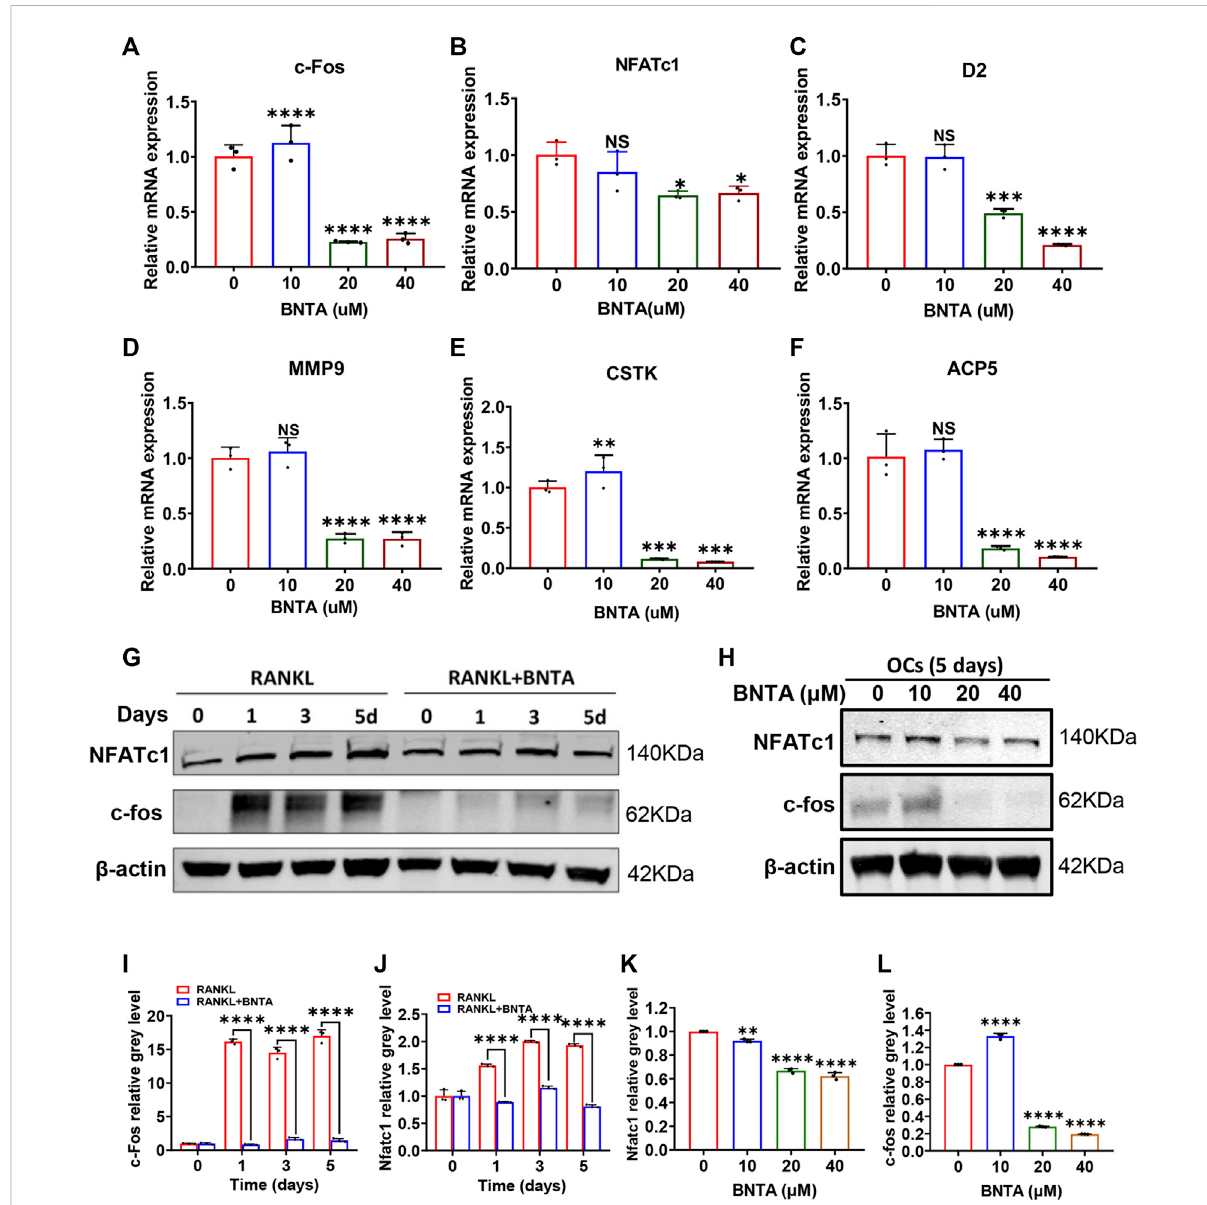
FIGURE 3 BNTA attenuated osteoclast-related gene expression and inhibited NFATc1 activation. (A – F) qPCR analysis of osteoclast-related gene expression of c-fos, NFATc1, D2, MM9, CSTK, and ACP5 relative to Control in BMMs stimulated by RANKL for 5 days with or without an indicated dose of BNTA ( n = 3 per group). All data are presented as mean ± SD. * p < 0.05, ** p < 0.01, *** p < 0.001, **** p < 0.0001 compared with control group. (G) Representative Western Blot images of the effect of BNTA on the protein expression of NFATc1 and c-fos on days 0,1, 3, and 5 with the stimulation of RANKL. (H) Representative Western Blot images of the effect of BNTA on the protein expression of NFATc1 and c-fos at day 5 stimulated by RANKL with or without an indicated dose of BNTA. (I – L) Quantitative analysis of the ratio of band intensity of NFATc1 and c-fos relative to β -actin ( n = 3 per group). ** p < 0.01, **** p < 0.0001 relative to control